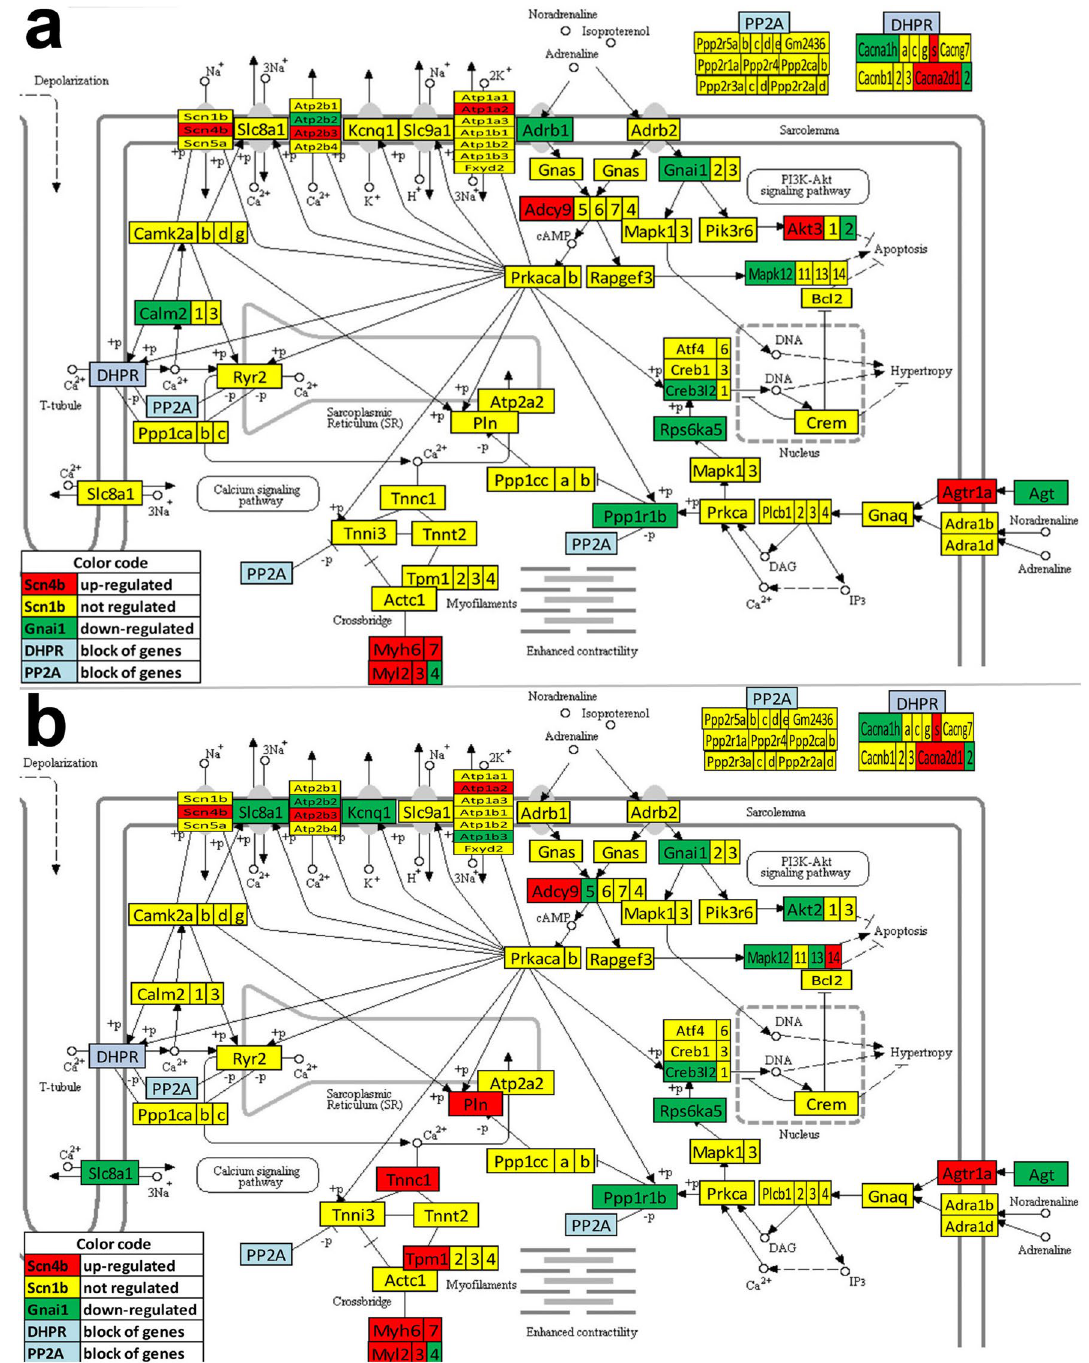
Figure 4. KEGG map ( modified from https ://www.genom e.jp/dbget -bin/www_bget?path:mmu04 261) of the differential expression of adrenergic signaling in cardiomyocytes (ASC) genes from: ( a ) the left ventricle vs left atrium and ( b ) the right ventricle vs right atrium. Red/green/yellow background of the gene symbol indicates up-/down-/not regulated. Genes with significant differences: adenylate cyclases ( Adcy5, Adcy9 ), adrenergic receptor beta 1 ( Adrb1 ), angiotensinogen ( Agt ), angiotensin II receptor type 1a ( Agtr1a ), thymoma viral proto- oncogenes ( Akt2, Akt3 ), Ca ++ transporting ATPases ( Atp2b2, Atp2b3 ), Na + /K + transporting ATPases ( Atp1a2 , Atp1b3 ), calcium channels ( Cacna1h, Cacna1s, Cacna2d1, Cacna2d2 ), calmodulin 2 ( Calm2 ), cAMP responsive element binding protein 3-like 2 ( Creb3l2 ), potassium voltage-gated channel subfamily Q member 1 ( Kcnq1 ), mitogen-activated protein kinases ( Mapk12, Mapk13, Mapk14 ), heavy ( Myh6, Myh ) and light myosins ( Myl2, Myl3, Myl4 ), phospholamban ( Pln ), protein phosphatase 1 regulatory (inhibitory) subunit 1B ( Ppp1r1b ), ribosomal protein S6 kinase polypeptide 5 ( Rps6ka5 ), sodium channels ( Scn4b , Scn5a ), solute carrier family 8 (sodium/calcium exchanger) member 1 ( Slc8a1 ), troponin T1, skeletal, slow ( Tnnt1 ) and tropomyosin 1 alpha ( Tpm1